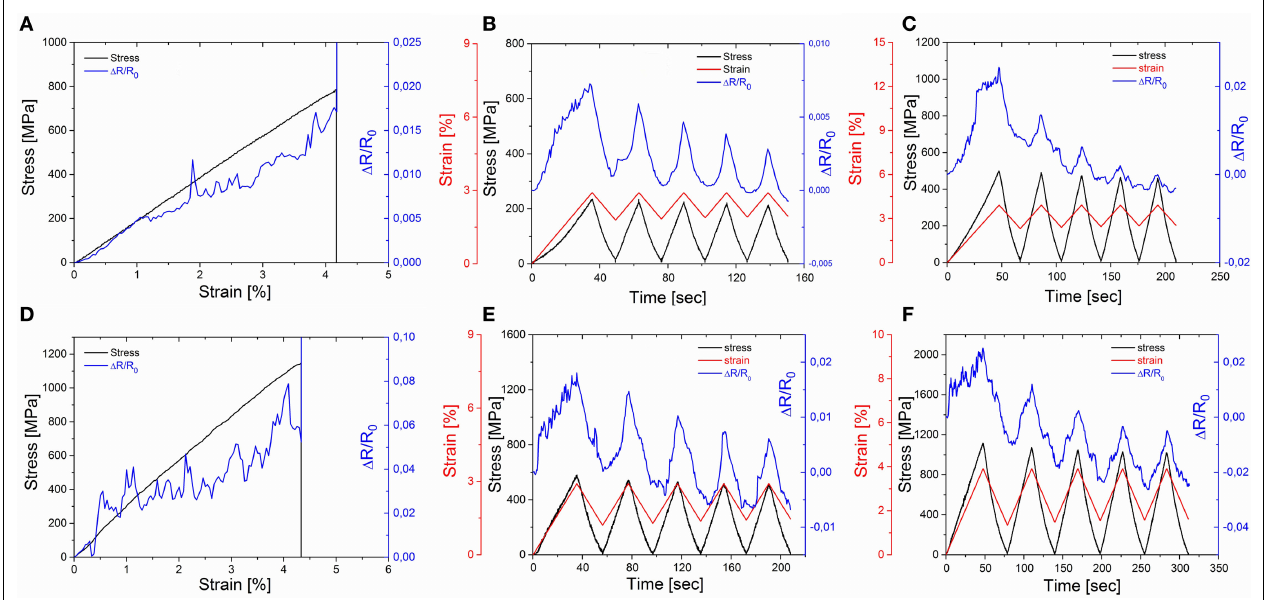
FIGURE 3 | Stress–strain behavior and electrical resistance change of reference CNT fiber (A–C) and epoxy resin treated CNT fiber (D–F) . (A,D) : stress, strain, and electrical resistance change plots as a function of time, (B,E) : cyclic loading for 3% strain. (C,F) : cyclic loading for 4%